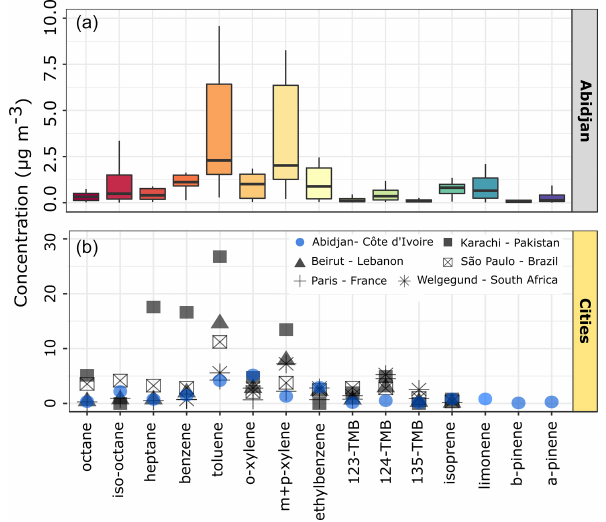
Figure 4. Boxplot showing the VOC concentrations (µgm − 3 ) at Abidjan ambient sites (a) . The middle line in each box plot indi- cates the median (50th percentile), the lower and upper box limits represent the 25th and 75th quartiles, respectively, and the whiskers the 99% coverage assuming the data have a normal distribution. (b) shows the mean concentrations reported in other cities world- wide, such as Abidjan – Côte d’Ivoire (this study), Paris – France (AIRPARIF, 2016), São Paulo – Brazil (Dominutti et al., 2016), Beirut – Lebanon (Salameh et al., 2014), Karachi – Pakistan